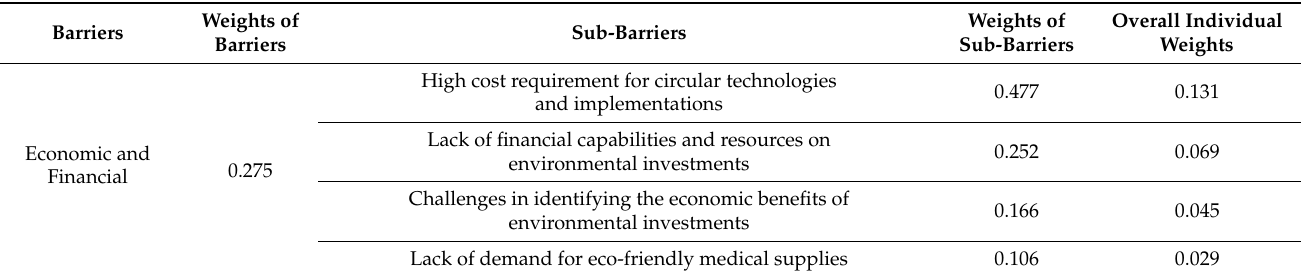
Table 5. Sub-Barrier